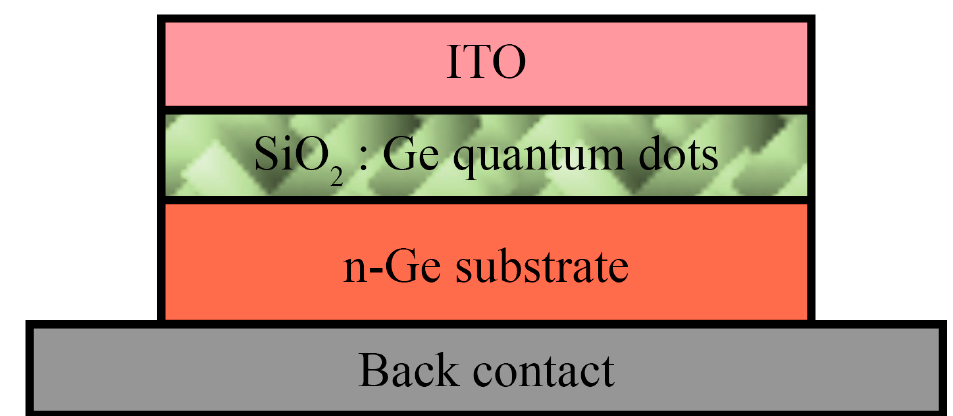
Figure 6. Schematic diagram of the photodetector consisting of an ITO electrode and an active layer with quantum dots on top of an n-Ge substrate.